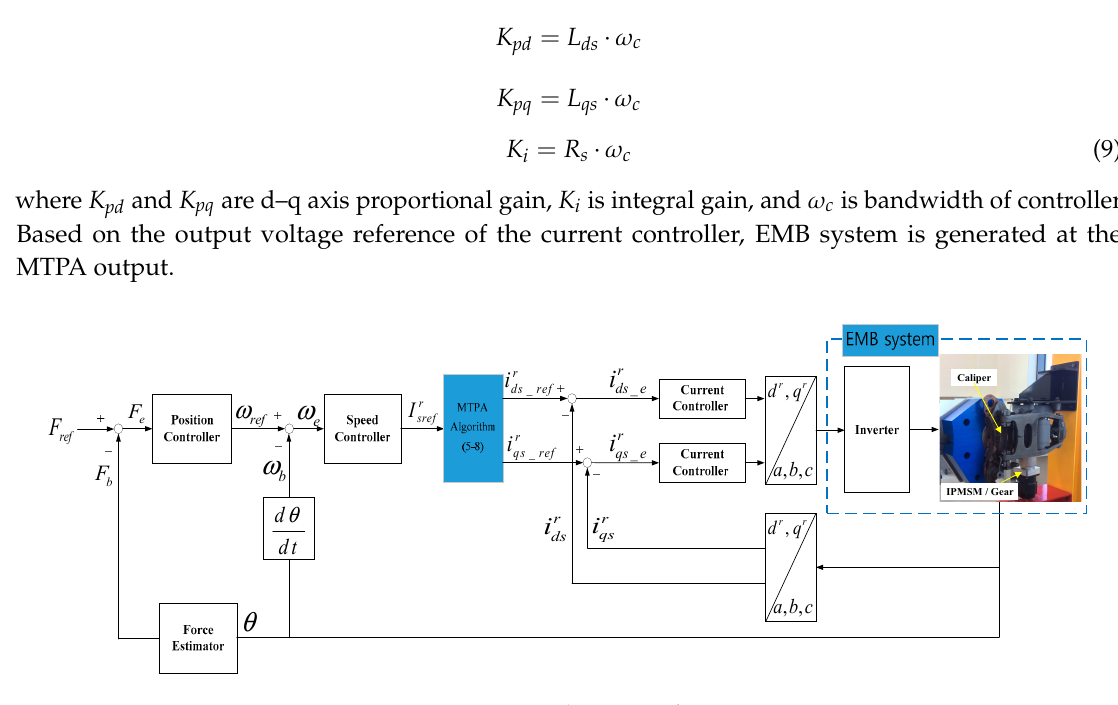
, i r qs , and β for IPMSM. ds i , r i , and β for IPMSM . ds qs